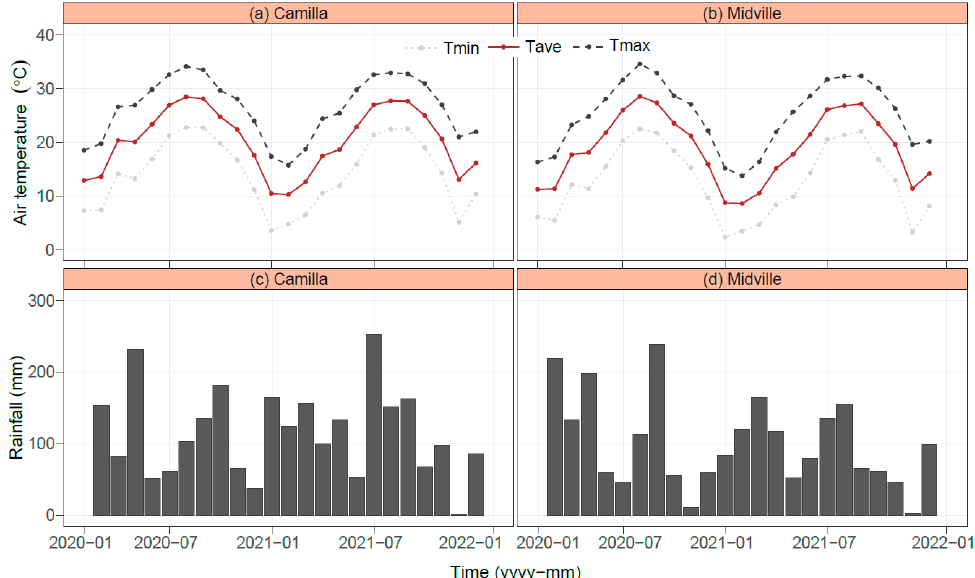
Figure 1. ( a , b ) Monthly minimum (Tmin), mean (Tave), and maximum (Tmax) air temperature, as well as ( c , d ) monthly total precipitation in Camilla and Midville, GA from 1 January 2020 to 31 December 2021.